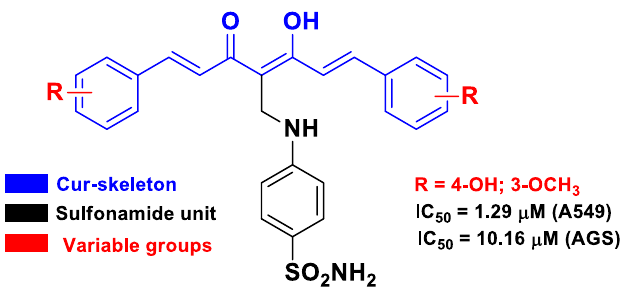
Figure 11. Structure and activity of the most potent hybrid compound developed by Banuppriya et al. [60].